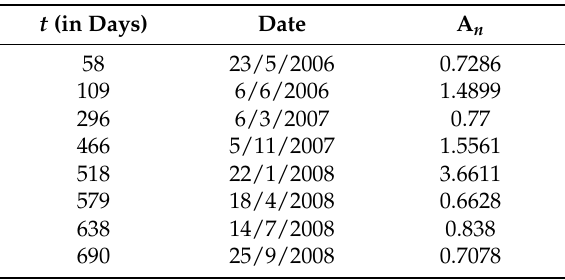
Table 12. Change points in the estimated negative jump time series of Google with the corresponding test statistic